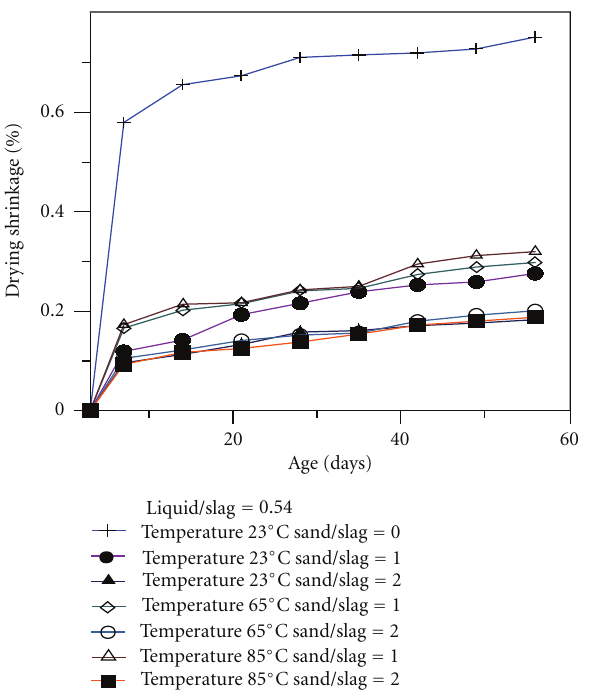
Figure 12: Drying shrinkage of AAS and Portland cement mortars. Table 4: Drying shrinkage of Portland cement mortars at wa- ter/cement ratio of 0.54